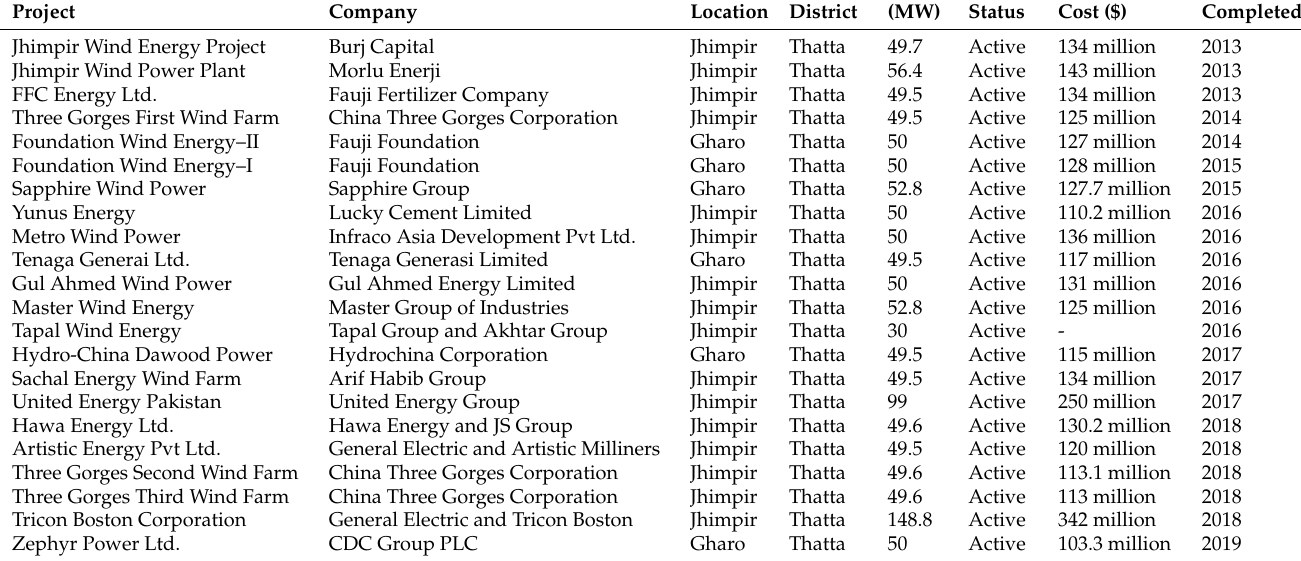
Table 5. Wind Power facilities in